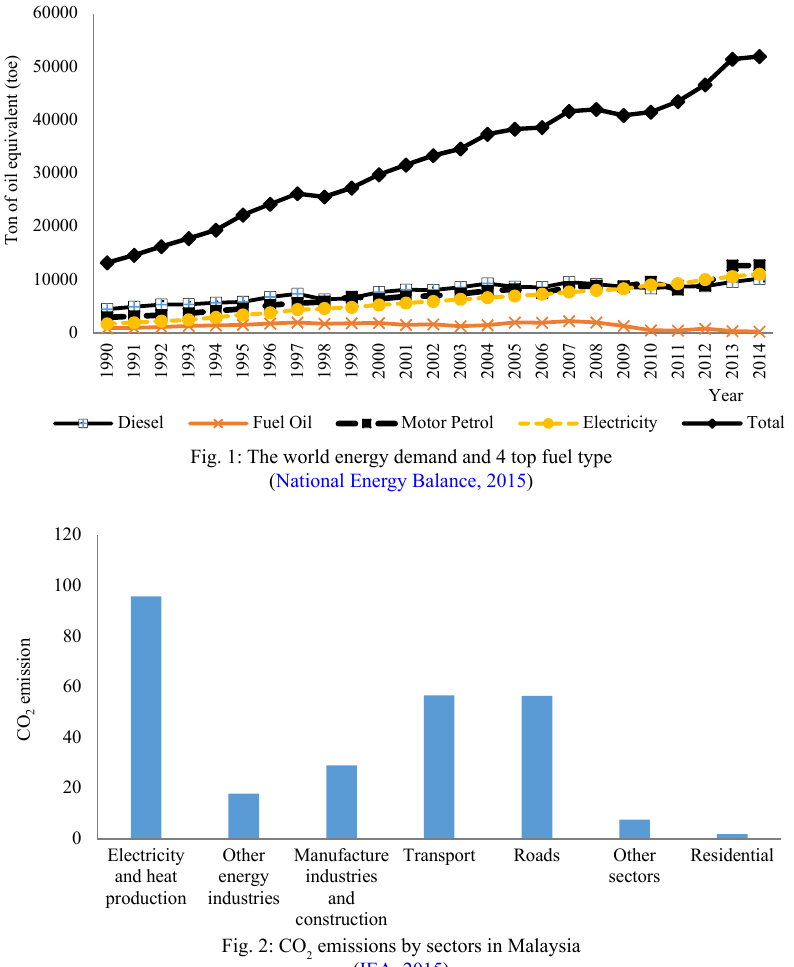
Fig. 2: CO emissions by sectors in Malaysia 2 (IEA, Fig. 2: CO 2 emissions by sectors in Malaysia (IEA, 2015)